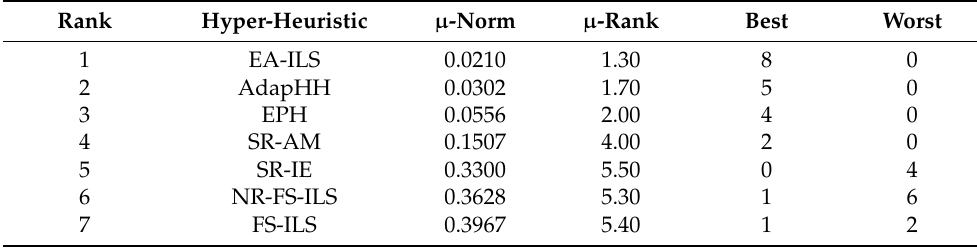
Table 5. Evaluation Results on the Knapsack